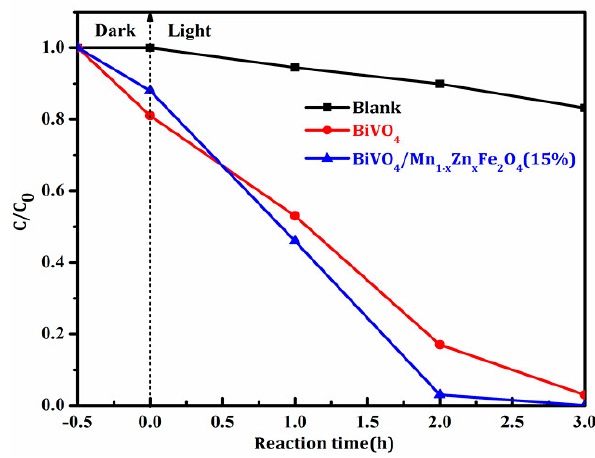
Figure 9. Photocatalytic degradation ratios of RhB with BiVO 4 and BiVO 4 /Mn 1 − x Zn x Fe 2 O 4 (15 wt %) samples.